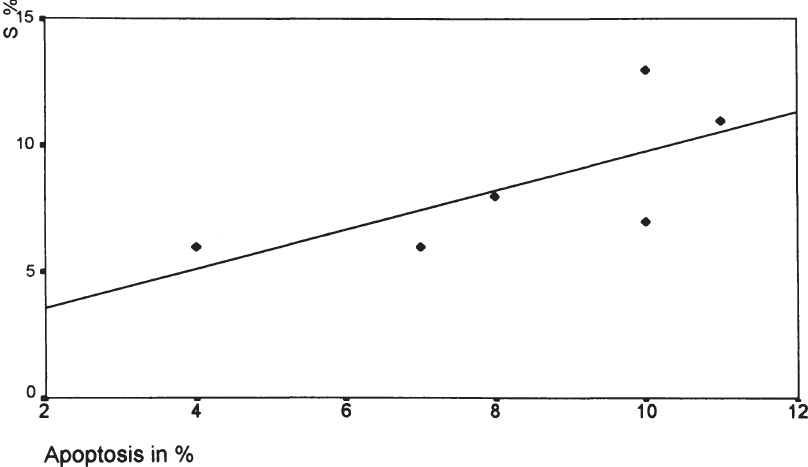
Fig. 5. Correlation between apoptosis and proliferation in tubulovillous adenomas, follow-up group, patients with carcinoma history: Apoptotic cells % vs. S % ( ρ = 0 . 875, p < 0 . 02, N = 6). In adenomas, there are no obvious differences which may be due to whether a history of malignancy exists or not. The apoptotic fraction does not change in tubular adenomas compared to mucosa. In tubulovillous adenomas, it decreases considerably below the level of mucosa or tubular adenomas (8 ± 1 . 0 vs. 17 ± 2 . 5; 17 ± 1 . 5, p < 0 . 01). The percentage of Ki67 positive cells increases in tubular and tubulovillous adenomas compared to mucosa (39 ± 4 . 6; 42 ± 5 . 7 vs. 16 ± 3 . 7, p < 0 . 01). Both the proliferative compartment and Ki67 positive cells exceed the apoptotic fraction (Fig. 1, Table 2). Ki67 positive cells are predominantly present in the superficial layer with a high frequency in dys- plastic areas. This corresponds to known facts [4,19]. In cases without cancer history, the proliferative parameters S and G2M phase fraction are related in tubular adenomas ( ρ = 0 . 457, p = 0 . 02, N = 25). A positive relation between the apoptotic fraction and the S phase fraction is evident in tubulovillous adenomas ( ρ = 0 . 875, p = 0 . 02, N = 6) (Fig. 5). The same applies to all adenomas of the follow-up group ( ρ = 0 . 354, p = 0 . 034, N =